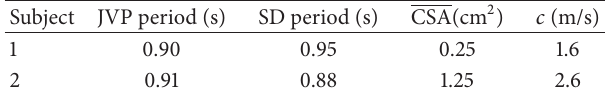
algorithm described in [4]. The period 𝑇 of the IJV pulsation Table 1: Time period for jugular venous pulse (JVP) and spectral Doppler (SD) periodic diagram is reported for two healthy subjects together with the time averaged internal jugular vein (IJV) cross- sectional area (CSA) and the wave propagation velocity 𝑐